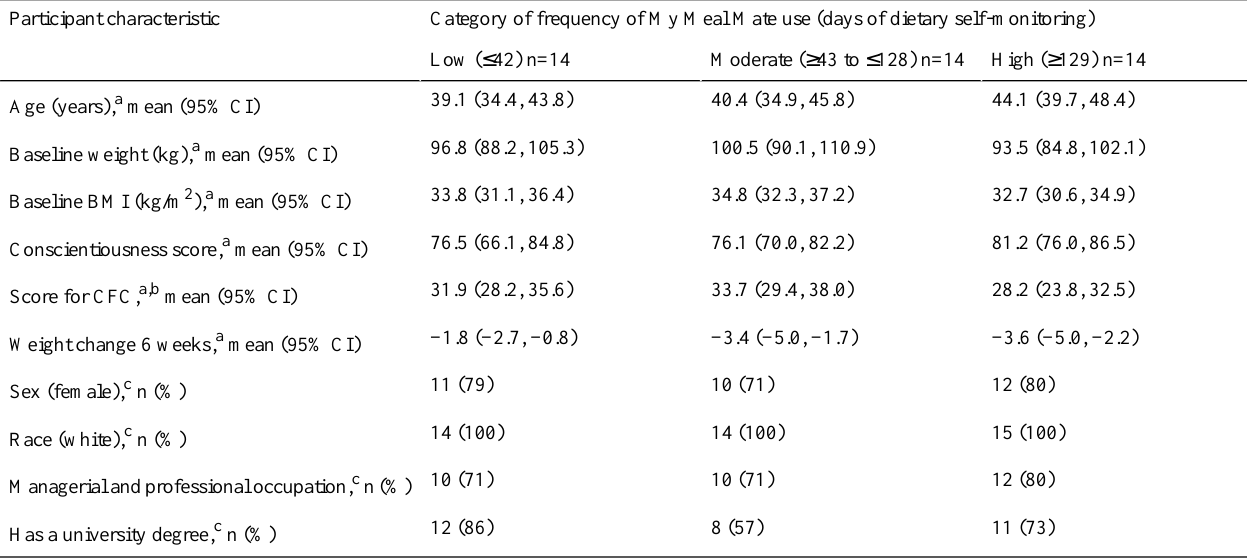
Table 2. Baseline characteristics of different categories of subsequent My Meal Mate use.